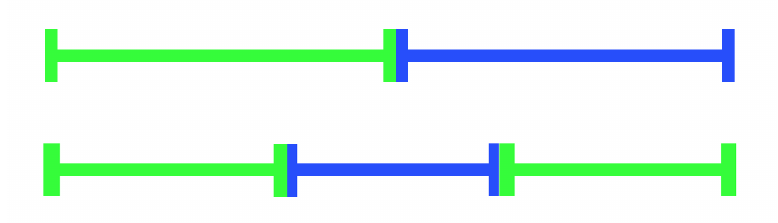
Figure 2: Perimeter-minimizing double bubbles in R with strictly log-convex C 1 symmetric density can consist of two or three contiguous